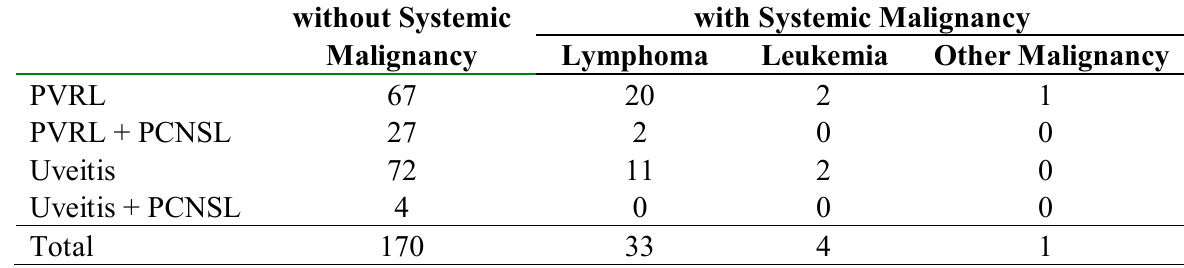
Table 3. Distribution of systemic malignancies in patients with masquerade syndrome.